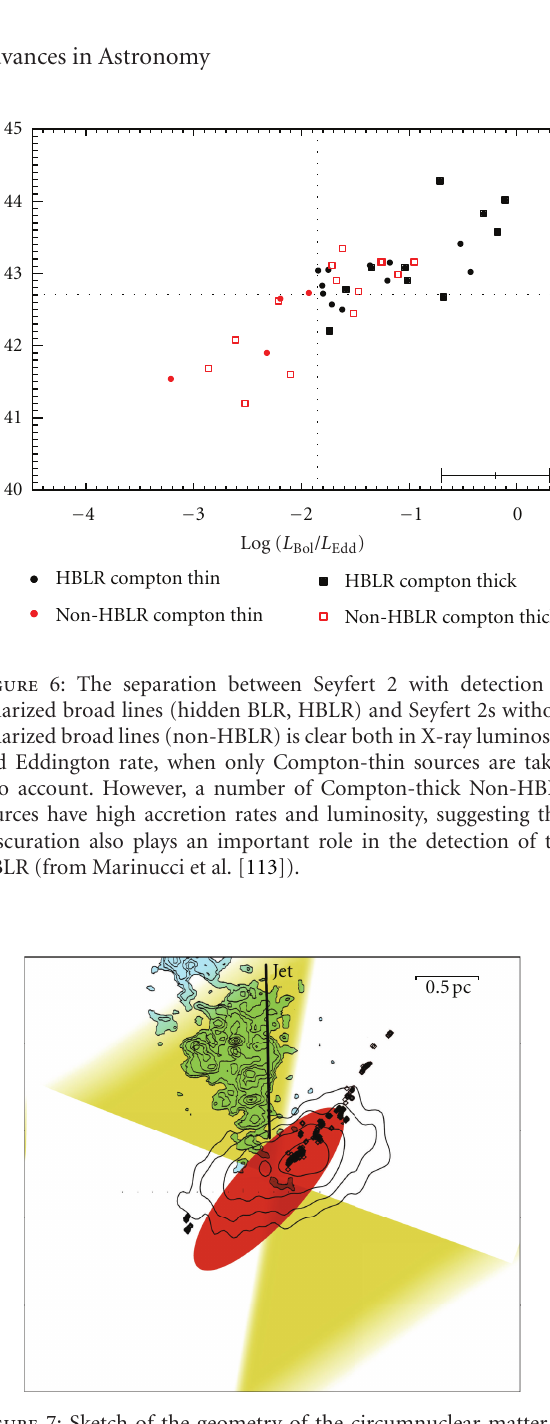
Figure 7: Sketch of the geometry of the circumnuclear matter in NGC 1068: compact dust inferred from mid-infrared interferome- try (red), ionization cones as mapped by the [OIII] emission (blue, reduced in scale by a factor ∼ 100) and as inferred from spectroscopy (yellow). From Raban et al.